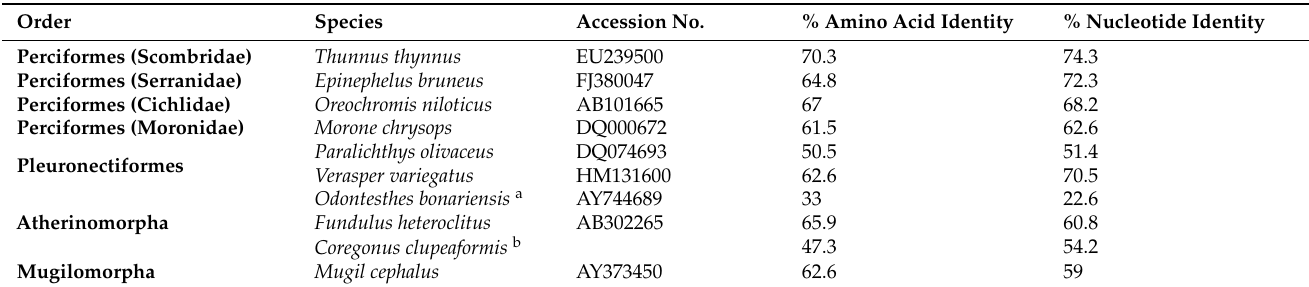
Table 1. Nucleotide and amino acid similarities (%) between cDNA sequences of GnRH1 of blue gourami and other teleosts [31]. Notes: a Pejerrey-type GnRH sequence, b Whitefish-type GnRH sequence.